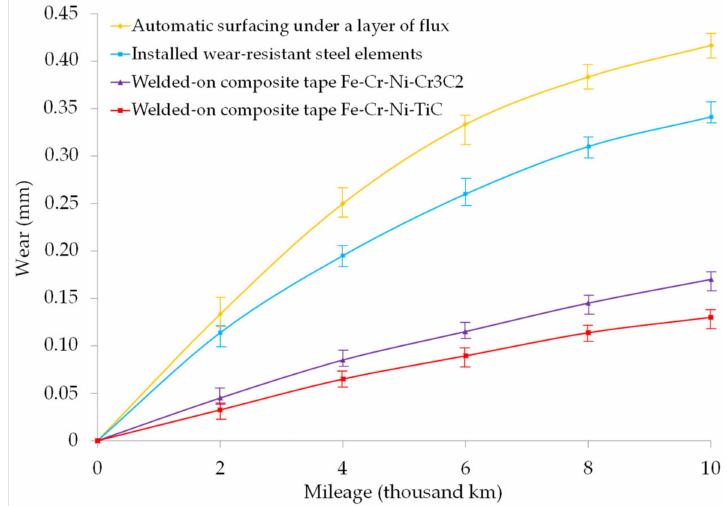
Figure 9. The total value of the wear of the center plate assembly for the case of an empty load of a freight car, in function of the mileage for the repaired CBRTB in function of the